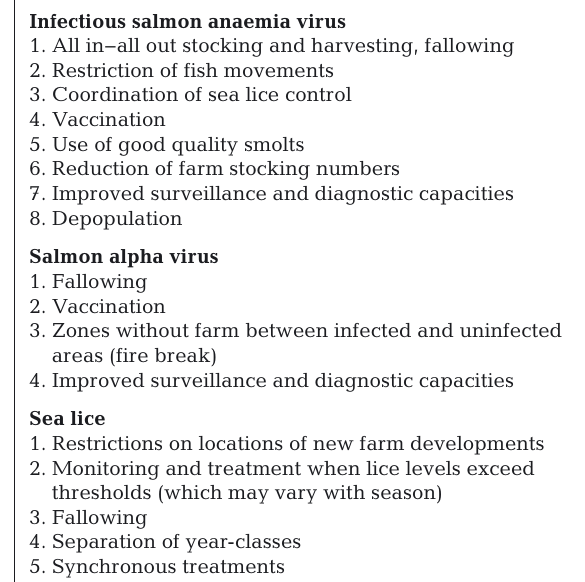
Table 1. Measures to mitigate pathogen introduction, dis- semination and consequences in